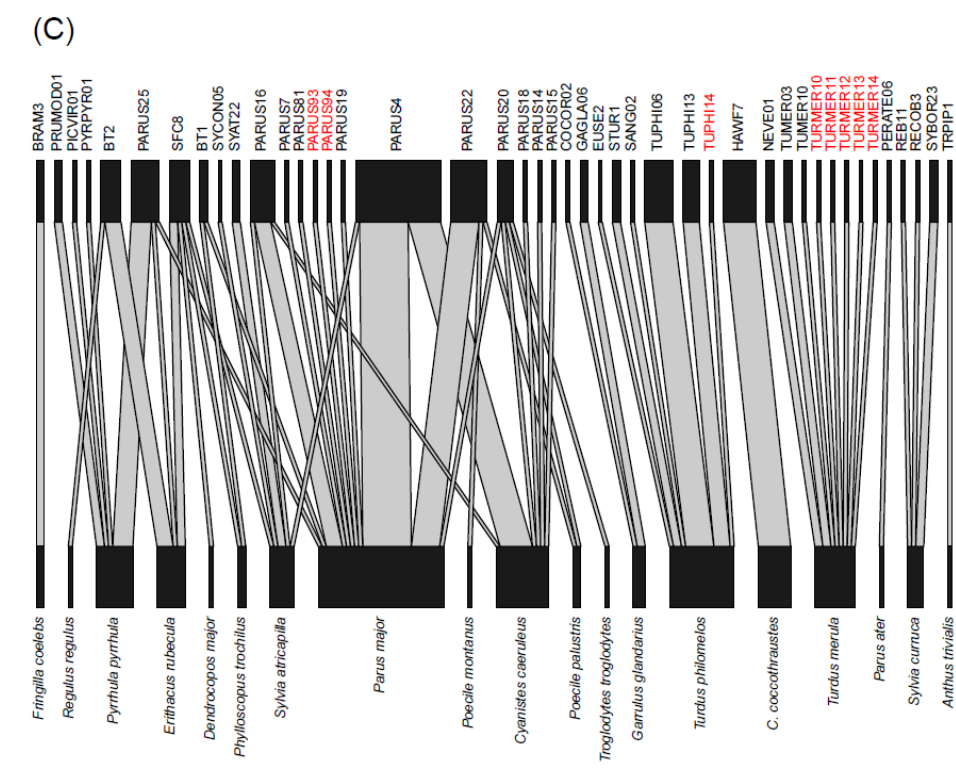
Figure 6. Bipartite plots on the host–parasite networks for haemosporidian parasites and avian species in Drienovec, Slovakia, during 2017, 2018 and 2019. Bipartite plots are shown for ( A ) Haemoproteus , ( B ) Plasmodium , and ( C ) Leucocytozoon lineages. Lineage names detected in this study are shown in red.